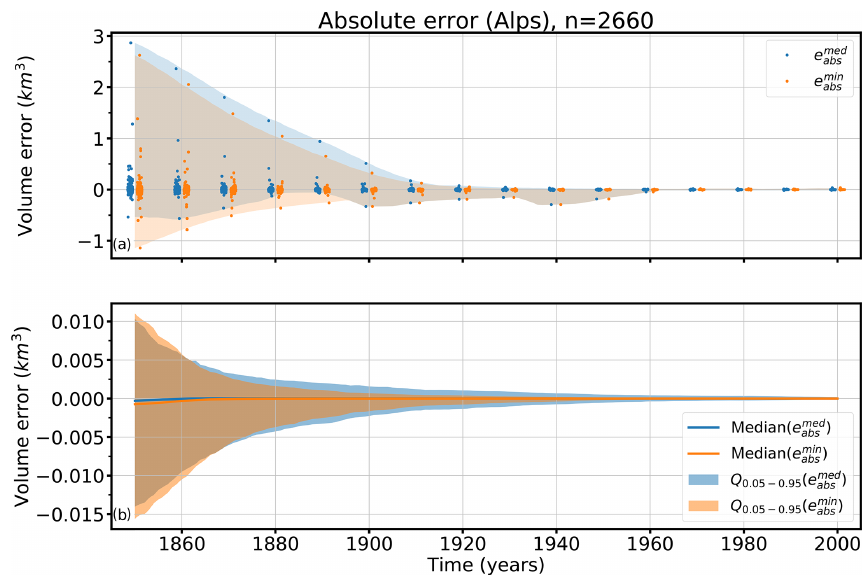
Figure 7. Absolute volume errors in cubic kilometers over time of s min t and s med t of all tested glaciers. (a) The blue points mark all individual errors e med of s med t and the orange points mark all individual errors e min abs e med and the orange shadowed area the total range of errors e min abs ( Q 0.05–0.95 ) of the absolute volume errors e med (orange